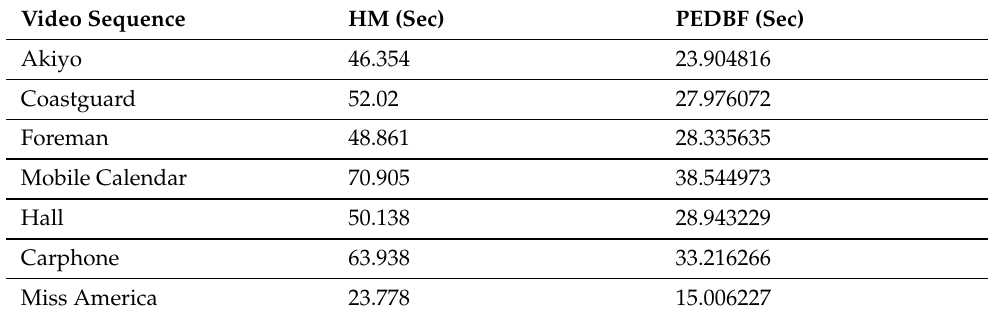
Table 7. Processing time of QCIF video sequences with QP = 37.